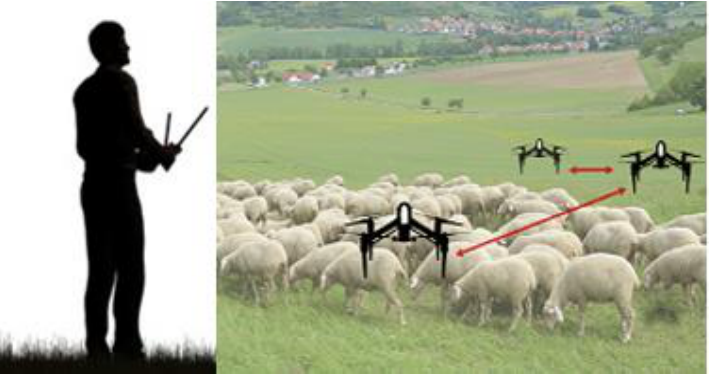
Figure 1. Conceptual Framework.